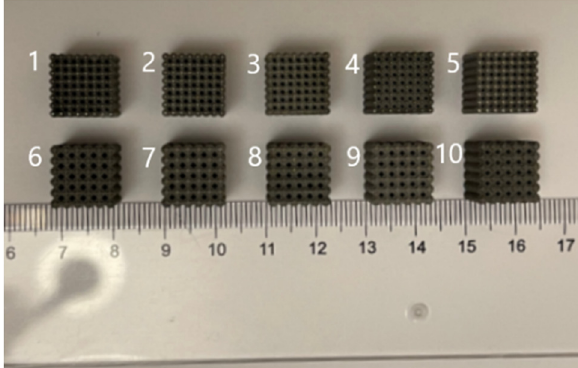
Figure 8: The model printing position and schematic diagram of model placement. Figure 9: Ten specimens with di ff erent lattice